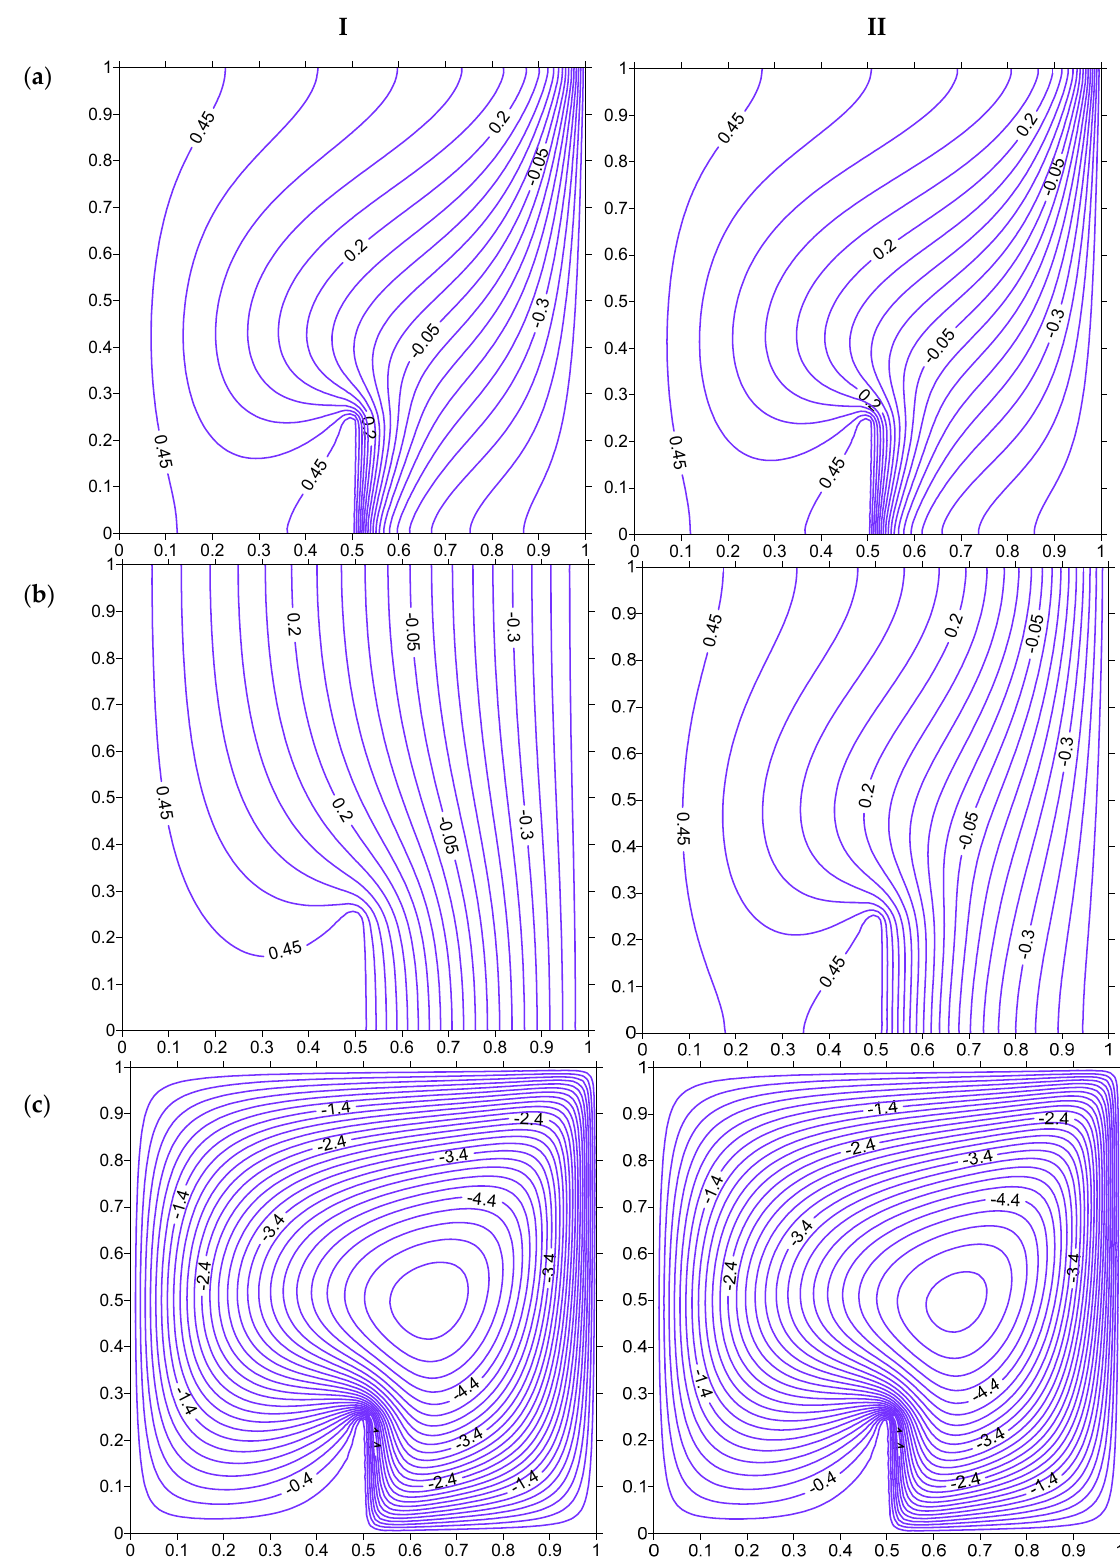
Figure 23. Isotherms (( a ) Fluid, ( b ) Solid), and streamlines ( c ), at Ra = 100, HH = 25%, Kr = 1, Rd = 0 for strip at x = 0.5. ( I ) Kr = 0.1. ( II ) Kr =